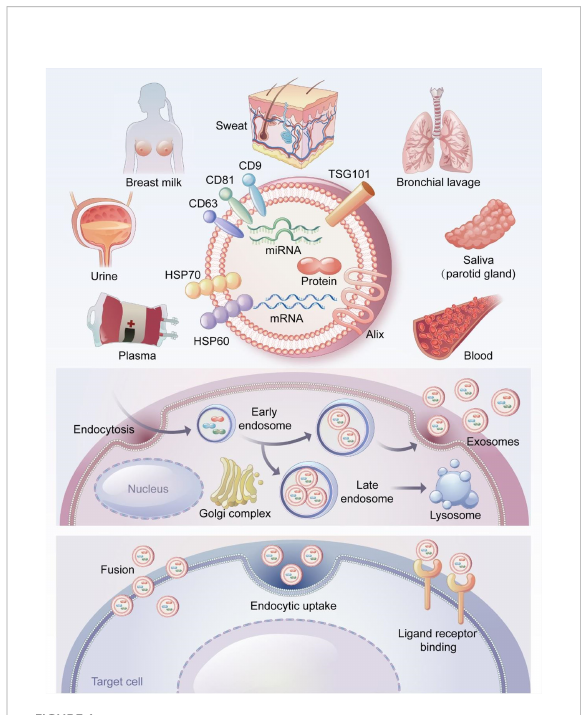
FIGURE 1 The source, formation process and surface markers of exosomes and the way of entering cells. Exosomes are derived from a variety of body fl uids, such as saliva, breast milk, bronchoalveolar lavage fl uid, urine, sweat, blood and plasma. CD9, CD63, CD81, TSG101, Alix and HSP70 are the most common exosome surface-speci fi c protein markers. Early endosomes germinate to form multivesicular bodies containing multiple luminal vesicles, the binding of multivesicular bodies to lysosomes results in material degradation. In contrast, fusion with the cytoplasmic membrane leads to the release of intraluminal vesicles outside the cell. These intraluminal vesicles are called exosomes. Exosomes can directly fuse with the cell membrane of target cells, or uptaken by target cells through endocytosis. In addition, exosomes can also bind to speci fi c receptors on the surface of target